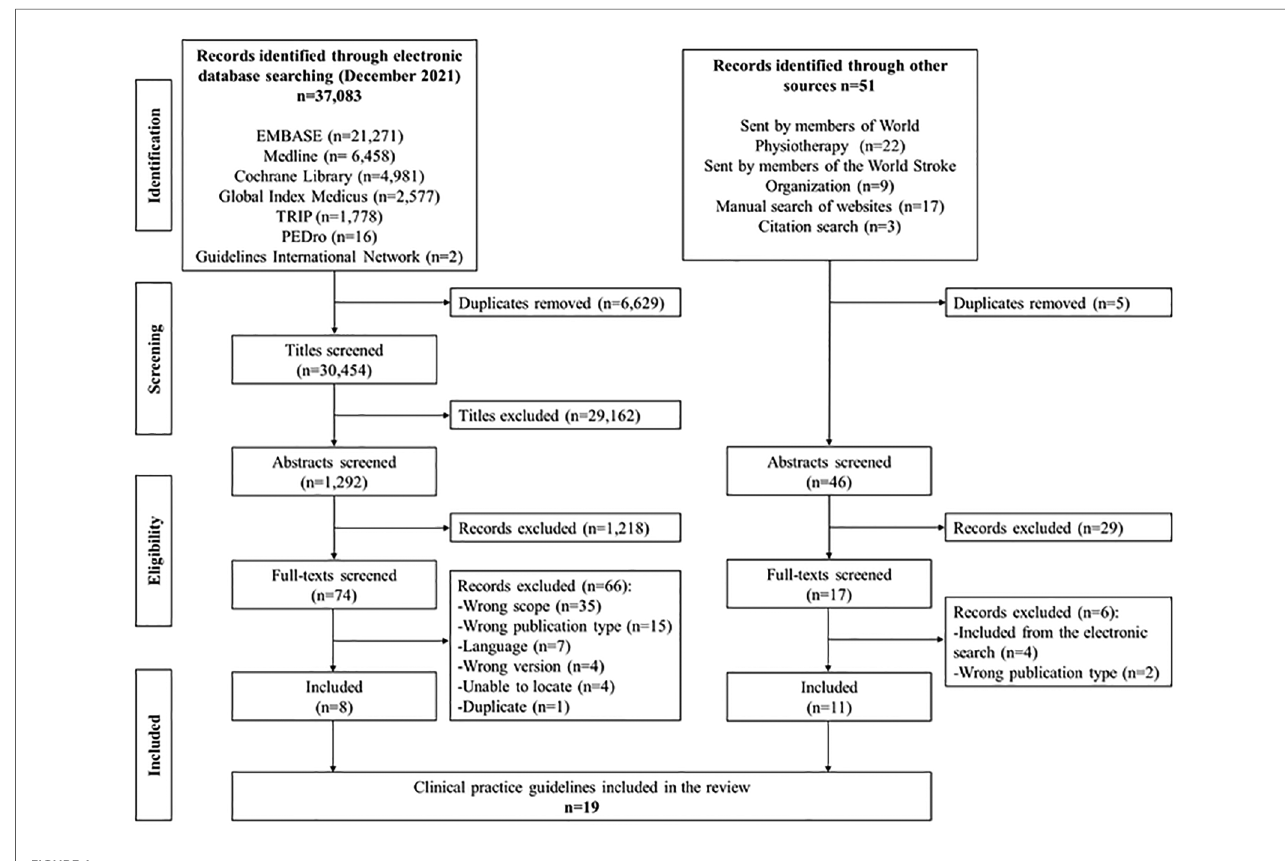
FIGURE 1 Results of guideline searching and